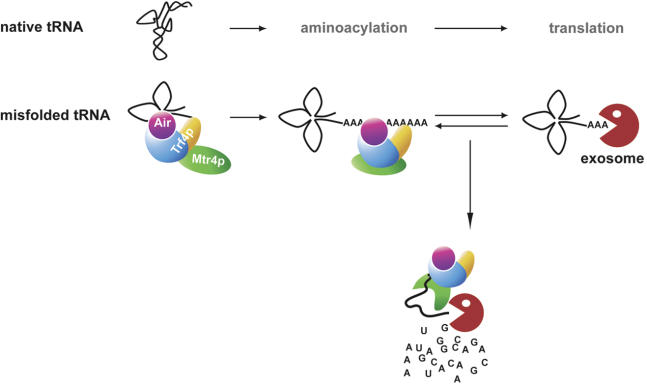
Model of the tRNA surveillance mechanism via polyadenylation of misfolded RNA by Trf4 complex leading to degradation by the exosome